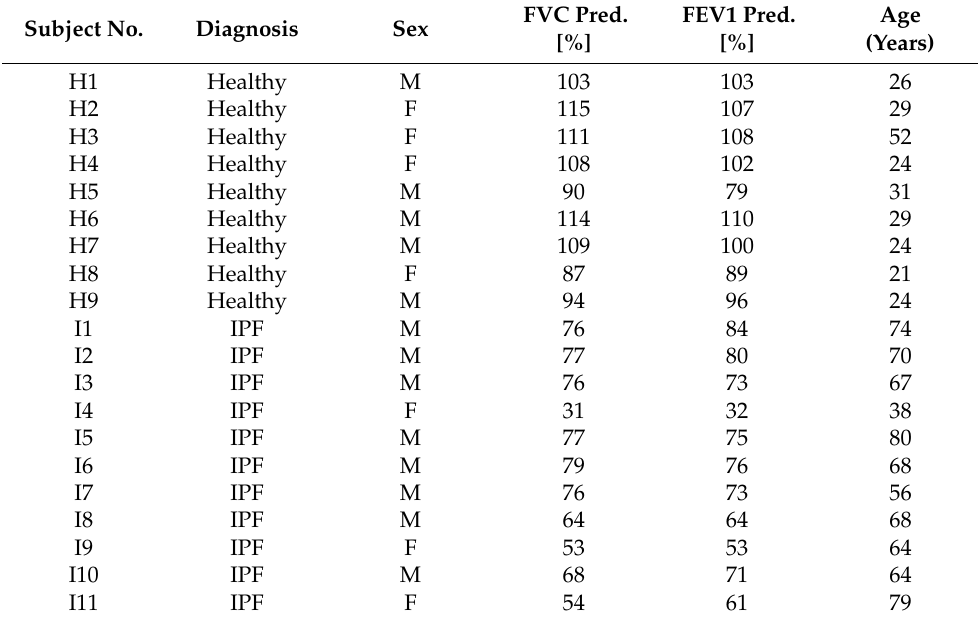
Table 1. Subject data for healthy ( n = 9) and IPF ( n = 11)